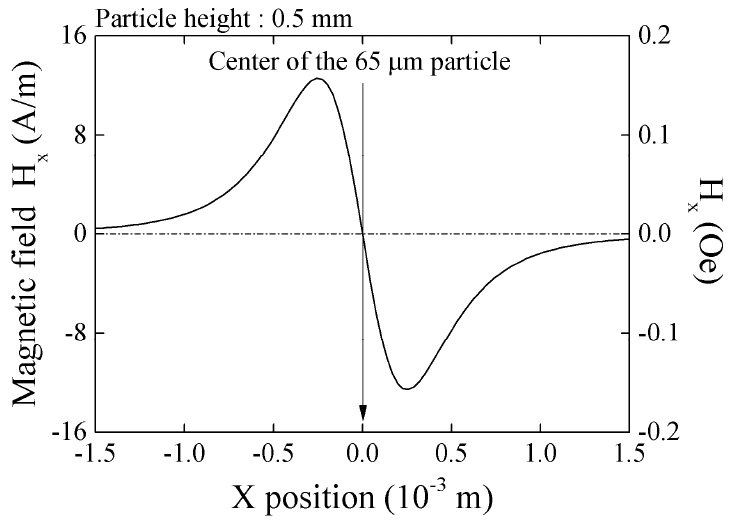
Figure 25. Calculated X-directional field on X -axis made by 0.2 T magnetized ϕ 65 µ m particle, placed on z = 0.5 mm [21].